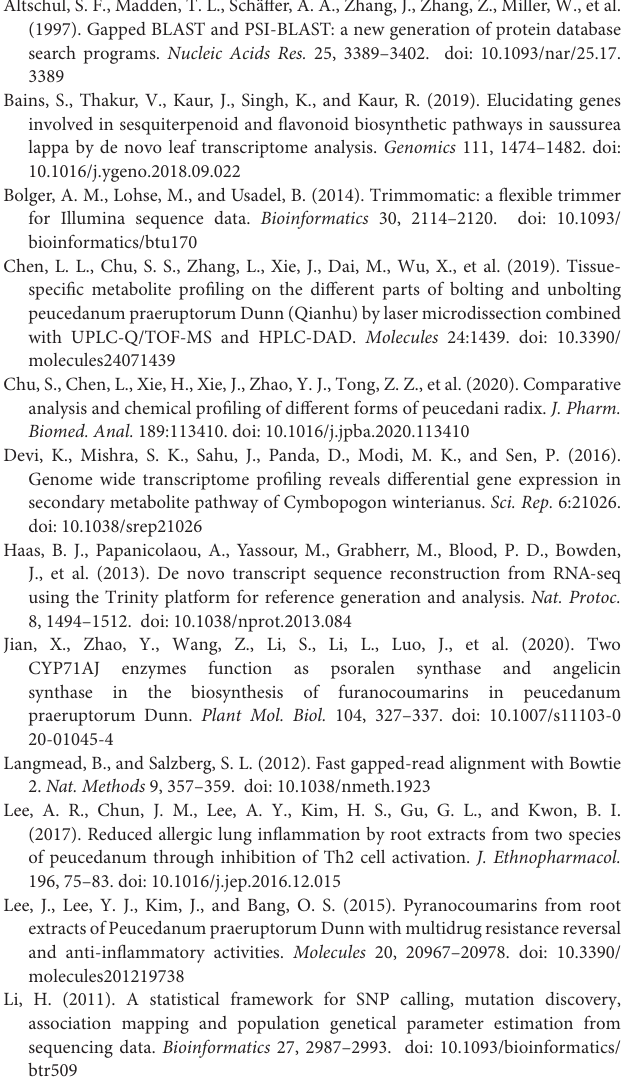
Supplementary Figure 4 | The TOM plot with cluster dendrogram. The yellow matrix across diagonal represents the correlation between modules, and the density represents the number of co-expressed genes. Supplementary Figure 5 | The module membership of different conditions with gene significant weight. (A) Annually grown at drawn phase. (B) Annually grown at undrawn phase. (C) Annually grown in north slope. (D) Annually grown in south slope. (E) Biennially grown at drawn phase. (F) Biennially grown at undrawn phase. Supplementary Table 1 | The software version and R packages used in the experiment. Supplementary Table 2 | The detailed information of the samples in the experiment. Supplementary Table 3 | The QC data statistics of all samples.